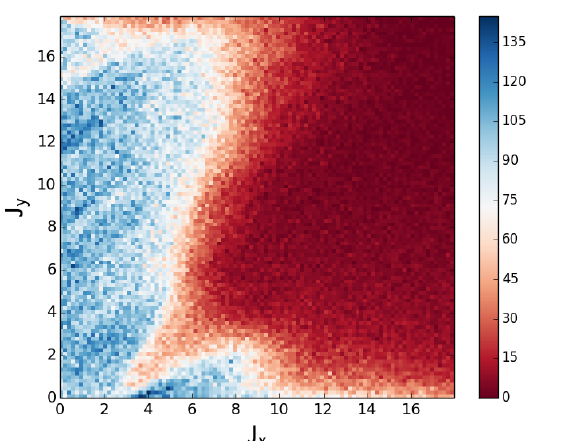
Figure 10: Particle distribution in action space as computed from numerical simulations performed with SixTrack. The configuration refers to the LHC ring at injection energy with Landau octupoles powered with a current of 35 A. The colour scale indicates the num- ber of particles per